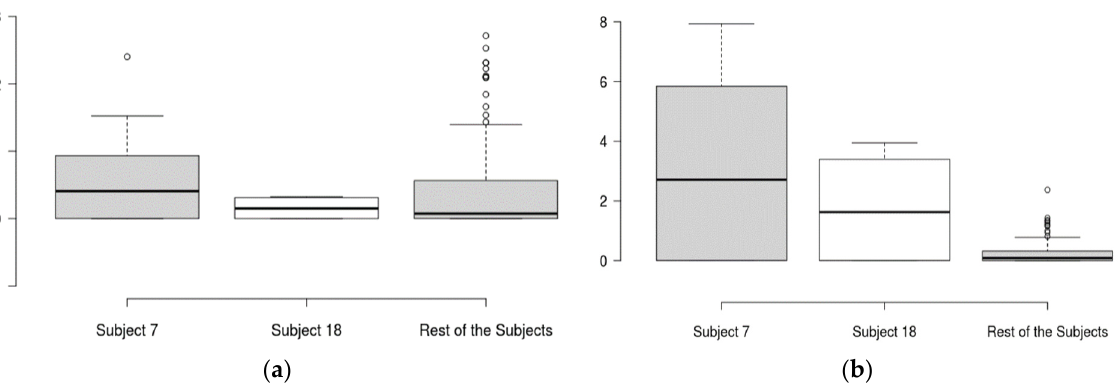
Figure 4. Box plot to see the distribution of raw EMG values for NP task in Session 1: ( a ) distribution of RBC muscle values of NP task in Session 1 ( b ) distribution of RFCR muscle values NP task in Session 1.